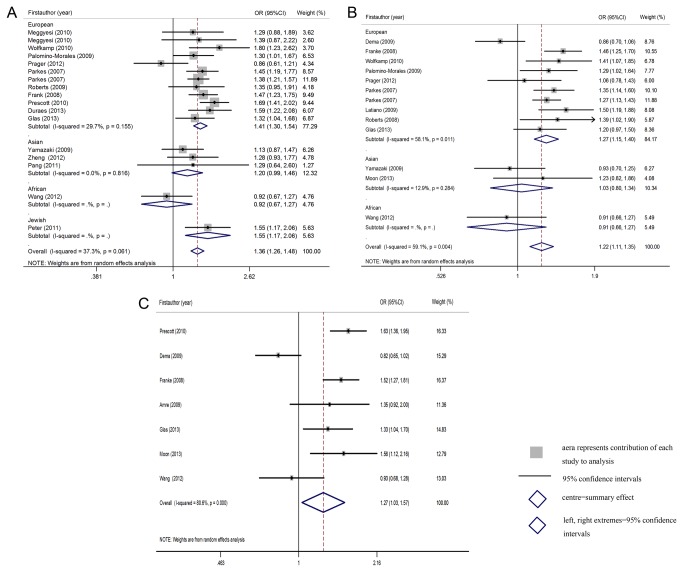
OR estimates with the corresponding 95% CI for the associations between IRGM polymorphisms ((A) rs13361189, (B) rs4958847, and (C) rs10065172) and the risk of CD (dominant model).The sizes of the squares reflect the weighting of included studies; the centre of diamonds reflect summary effect, the left and right extremes of diamonds reflect 95% confidence intervals; CI, confidence interval; OR, odds ratio.